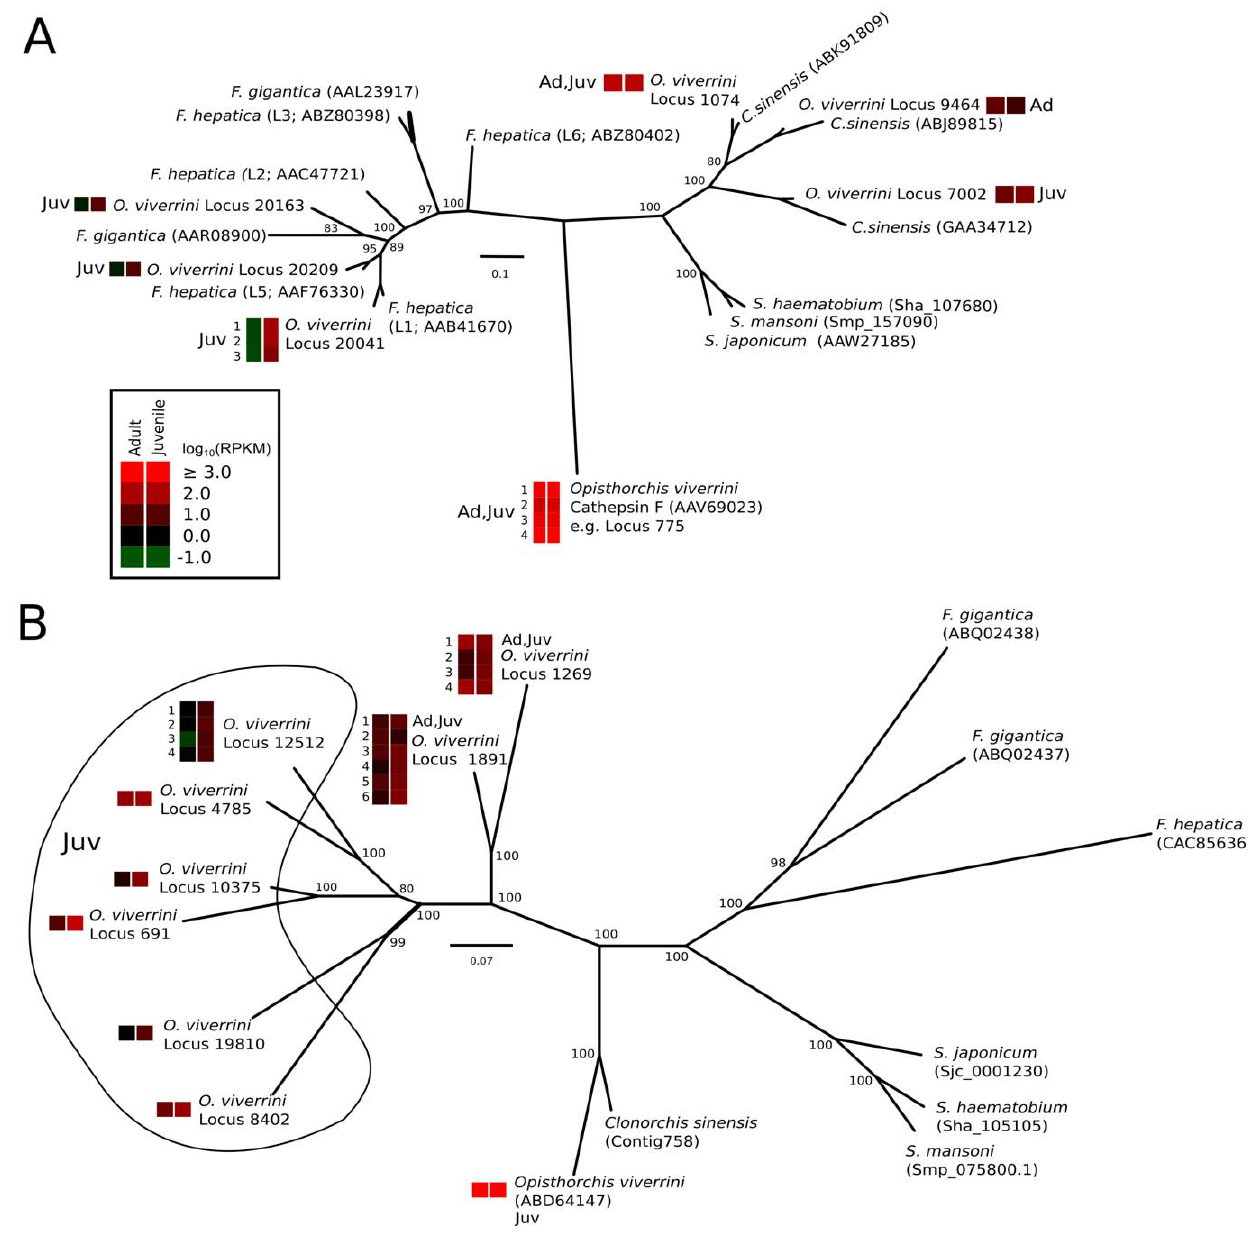
Figure 1. Phylogenetic relationships of key groups of cysteine proteases among selected parasitic trematodes. (A) cathepsin L and (B) asparaginyl endopeptidase (AEP) enzymes. Values indicated on the branches represent Bayesian inference bootstrap support. Opisthorchis viverrini sequences differentially (Ad or Juv) or constitutively (Ad,Juv) transcribed in the adult (Ad) or juvenile (Juv) stage are indicated. Transcription is expressed as log10-transformed reads per kilobase per million reads (RPKM). The GenBank accession number of each sequence is